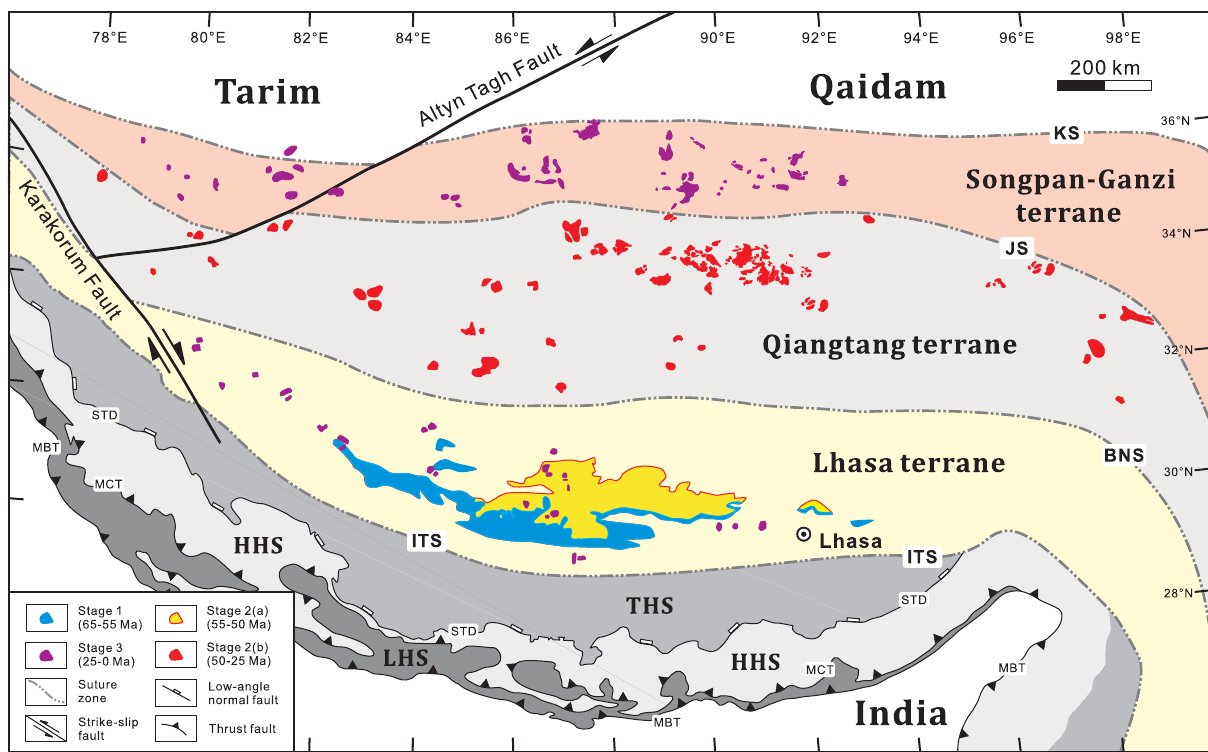
Fig. 1 Spatio-temporal distribution of Cenozoic three-stage magmatism in the Tibetan Plateau. Spatial distribution, geochronological and geochemical data for the magmatic rocks are taken from Supplementary Data 1 and 2. Stage 1 (65 – 55 Ma) formed in south Tibet (blue fi elds); Stage 2 (55 – 25 Ma) occurred in south-central Tibet, which includes Stage 2(a) in south Tibet (55 – 50 Ma; yellow fi elds) and Stage 2(b) in central Tibet (50 – 25 Ma; red fi elds); Stage 3 is distributed in south and north Tibet (purple fi elds). BNS Bangong – Nujiang suture, HHS higher Himalayan sequence, ITS Indus-Tsangpo suture, JS Jinsha suture, KS Kunlun suture, LHS lesser Himalayan sequence, MBT main boundary thrust, MCT main central thrust, STD south Tibetan detachment, THS Tethyan Himalayan (Table 1) of the eruptive ages in each volcanic fi eld of the Tibetan Plateau from ~65 Ma to the present. These reveal a near- continuous time-series of mean values of the ages in all volcanic fi elds in the Cenozoic (Figs. 3 and 4). The mean ages (Table 1 and Fig. 3) in the different volcanic fi elds from early to late Cenozoic are used as our modelling time-points in order to express subsequently a time series of the CCFM results.